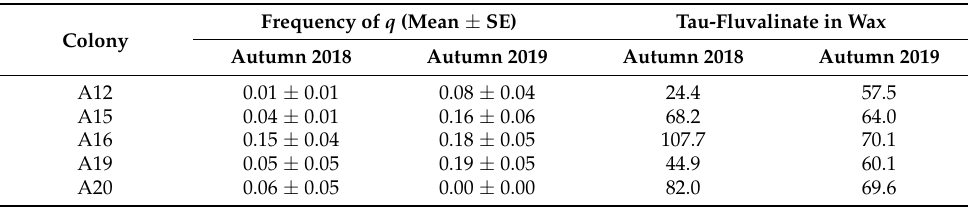
Table 3. Mean frequency ( ± SE) of the resistance allele ( q ) vs. levels of tau-fluvalinate in wax in the colonies that were alive at the end of the